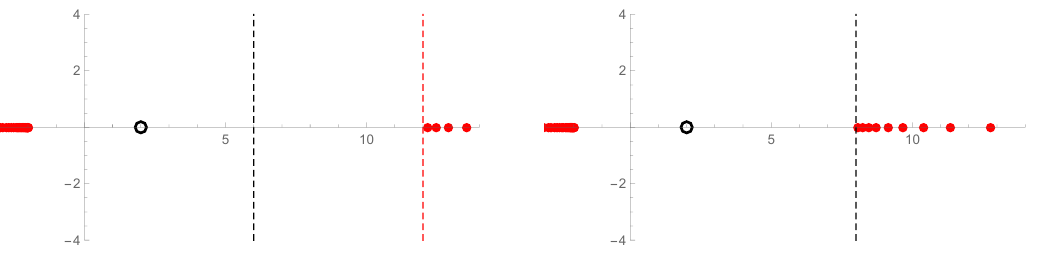
Figure 8 . The poles of the Borel-Padé approximant of the series ¯ e m in (4.53), for the O ( N ) non-linear sigma model, truncated at 120 terms. The plots correspond to N = 5 (left) and N = 6 (right). The leftmost dashed line (black) indicates the predicted position of the pole ζ = 2( N − 2) , the rightmost dashed line (red) is at ζ = 4( N − 2) and the black circle indicates the position of the removed IR singularity at ζ = 2 . For N = 5 the first singularity occurs at ζ = 4( N − 2)